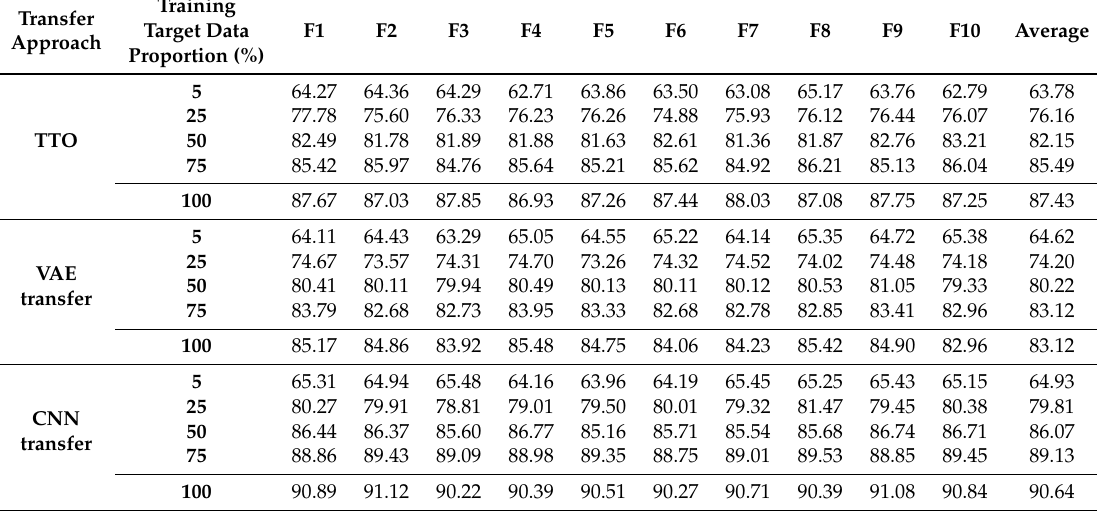
Table 11. 10-fold cross validation accuracies (in %) of TTO, VAE-transfer, and CNN-transfer after downsampling of the training set for the classification of VALENCE on the DEAP dataset. F i refers to fold number i